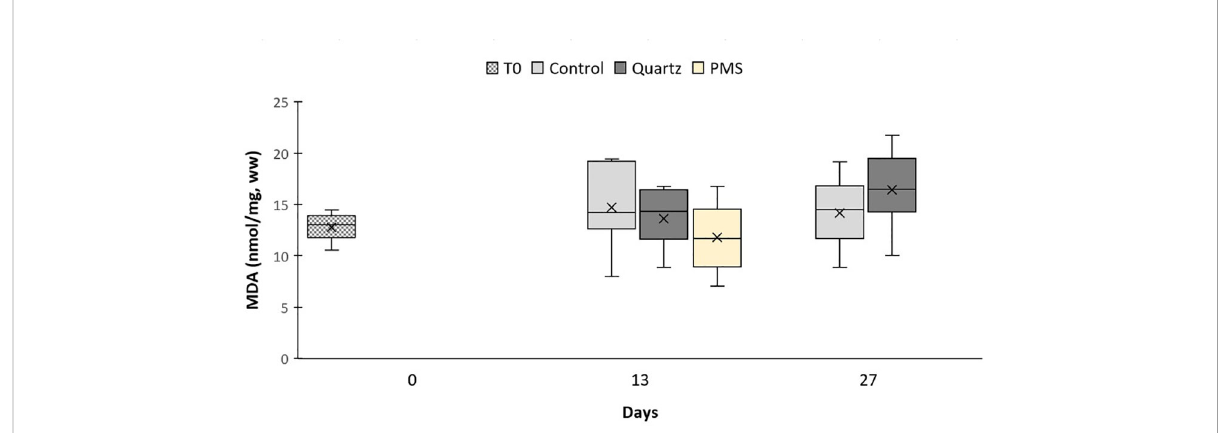
FIGURE 8 Concentrations of malondialdehyde (MDA) in Dentomuricea aff. meteor tissues during the experiment (times 0, 13, 27) in treatments with polymetallic particles (PMS), with quartz particles (Quartz) and in the control treatments with no sediment addition. N=3-6, no fragments in the PMS treatment at T27. The line in the box is the median, and the X is the mean. Whiskers represent the highest and lowest values and outliers are identi fi ed by a circle ( ○